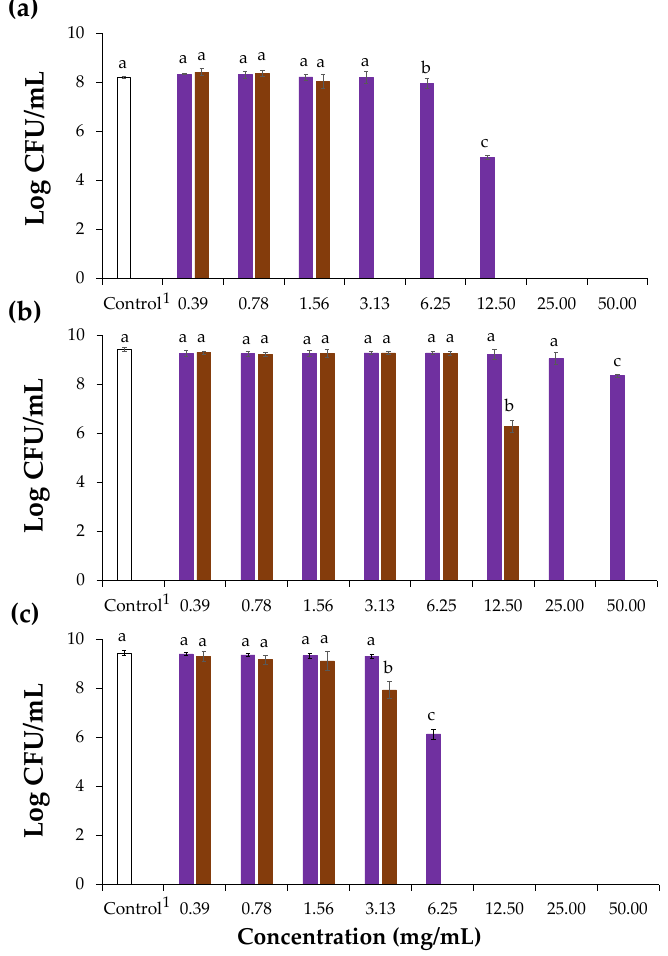
Figure 3. Effect of chicory (purple bars) and coffee (brown bars) high molecular weight material on the growth of S. aureus ( a ), L. monocytogenes ( b ), and B. cereus ( c ) represented as Log CFU/mL (CFU, colony forming units). 1 Control refers to assays with only the bacterial inoculum. Lowercase letters refer to significantly different values ( p < 0.05) in relation to each corresponding control.